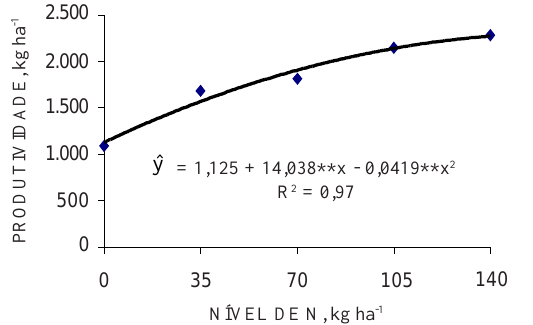
Figura 3. Produtividade de grãos de feijão, em função do nível de nitrogênio. ** significativo a 1%, pelo teste F.